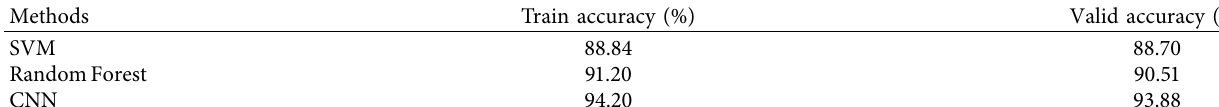
Table 2: Comparison with other methods.